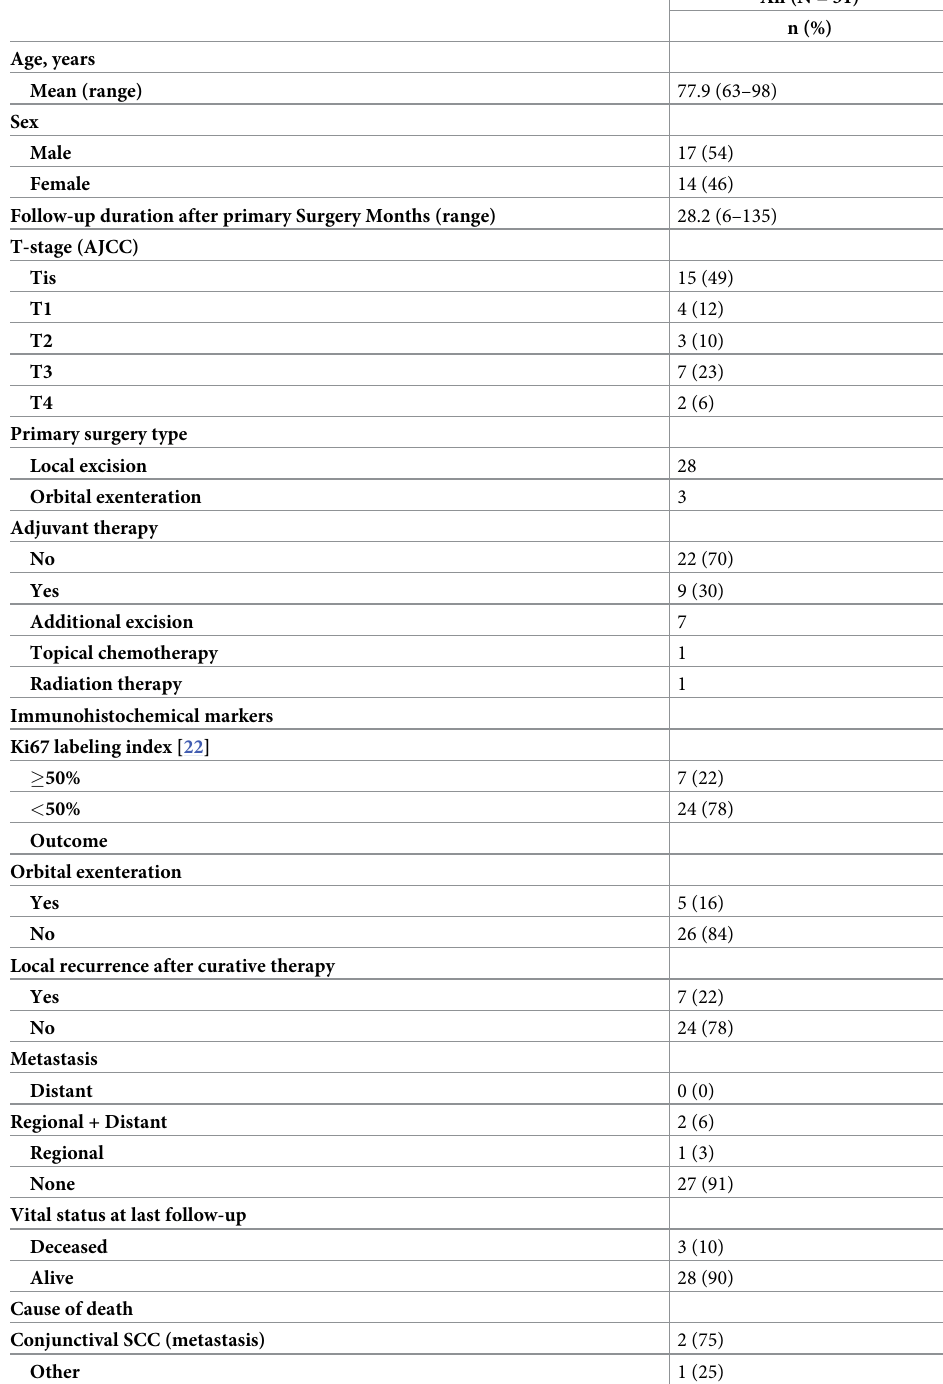
Table 1. Clinicopathologic findings of 31 cases of conjunctival squamous cell